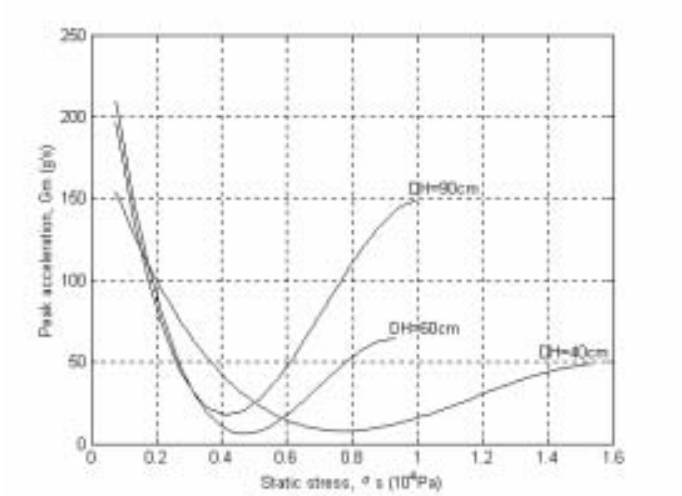
Fig. 8. Dynamic cushion curves of honeycomb paperboard ( T = 50 mm).